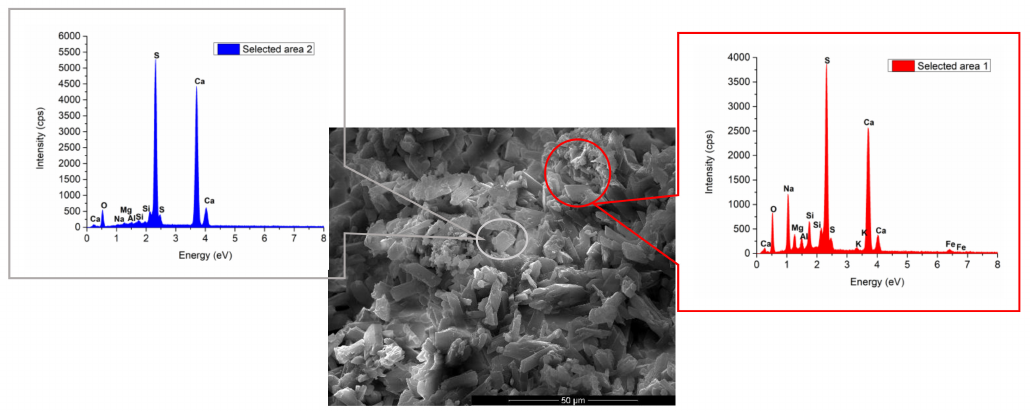
Figure 11. SEM and EDX analyses of IG1B1